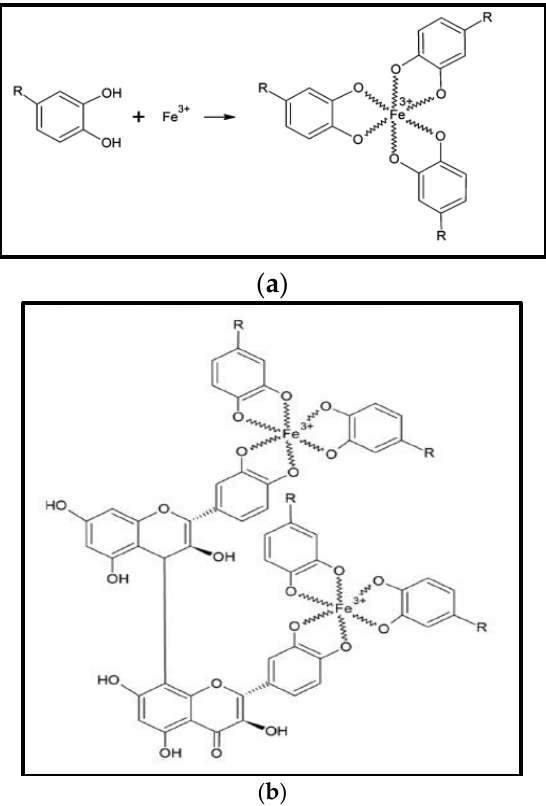
Figure 2. ( a ) Proposed chemical structure of Fe-P NPs [48]; and ( b ) proposed condensation mechanism of Fe-polyphenol [63].